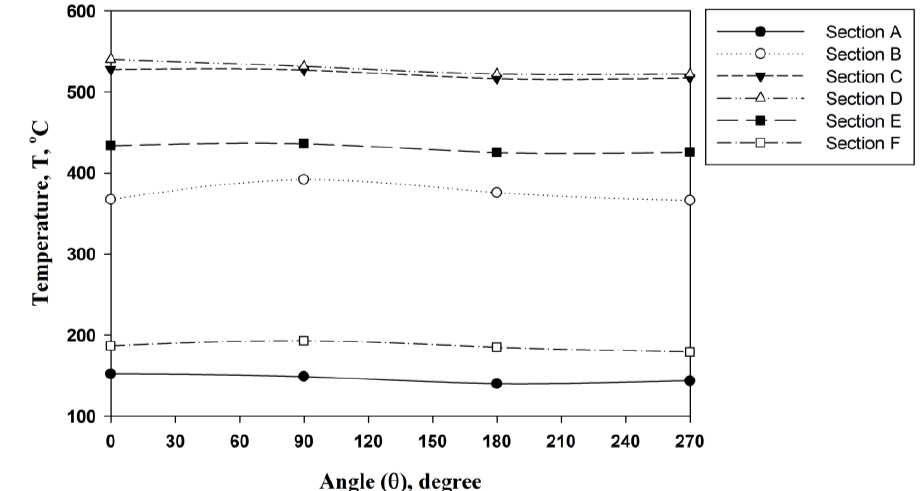
Figure 10: Circumferential temperature distribution in the PT